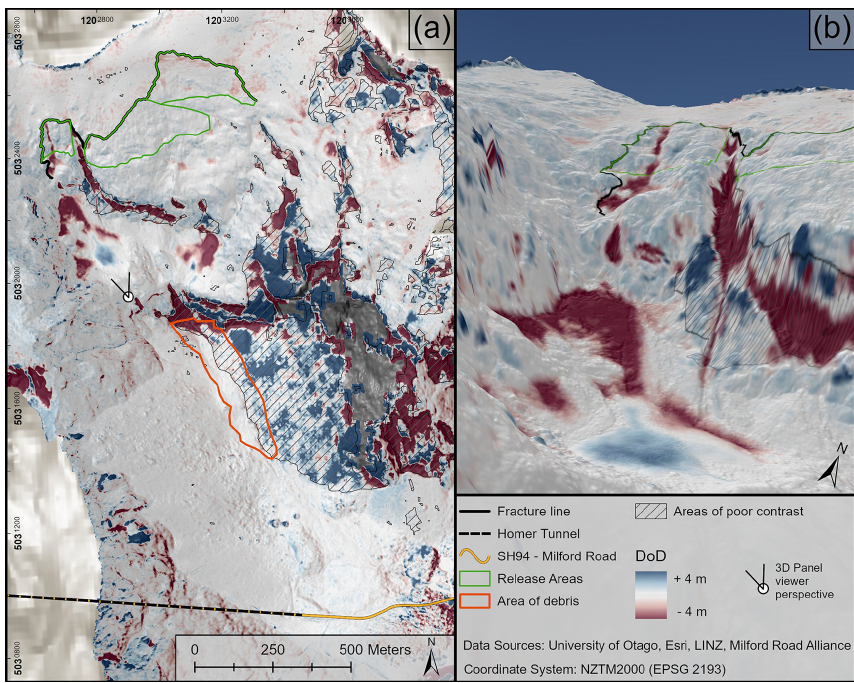
Figure 9. DEM of difference (DoD) map showing topographic differences between TLS 2m and SPM 2m DSMs. The areas of poor contrast in SPM imagery are shown with hash polygon. The 3D panel focuses on differences in topography where snow melt occurred between data acquisitions and on the extent to which gully features are resolved in the